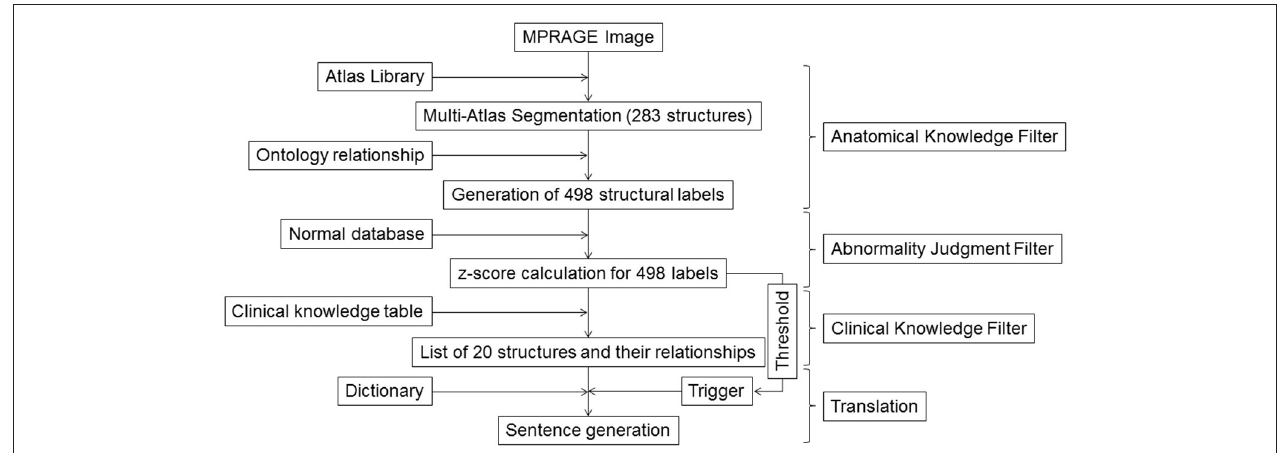
FIGURE 1 | Schematic diagram for the image–sentence conversion. MPRAGE images were first segmented into 283 structural units using a multi-atlas segmentation tool, from which an additional 215 superstructures were defined. This process of reducing an image with > 10 6 voxels to 498 structures was called the Anatomic Knowledge Filter . In the second step, called the Abnormality Judgment Filter , volumes of structures were compared with values retrieved from databases of healthy individuals, with z-scores (criteria for abnormality judgment) calculated. In the third step, z-score information for the 498 structures was reduced to information on 20 selected structures and their relationships, using a Clinical Knowledge Filter . The final step was the translation of this information to human-readable sentences using a dictionary. MPRAGE, magnetization-prepared rapid